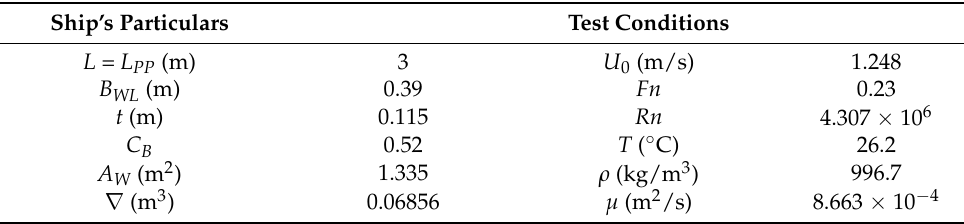
Figure 1. Ship geometry (side view) and control points (red hollow points) on the sonar dome (red surface). The lines are the surface outline. Table 1. Ship ’s main particulars and test conditions. Table 1. Ship’s main particulars and test